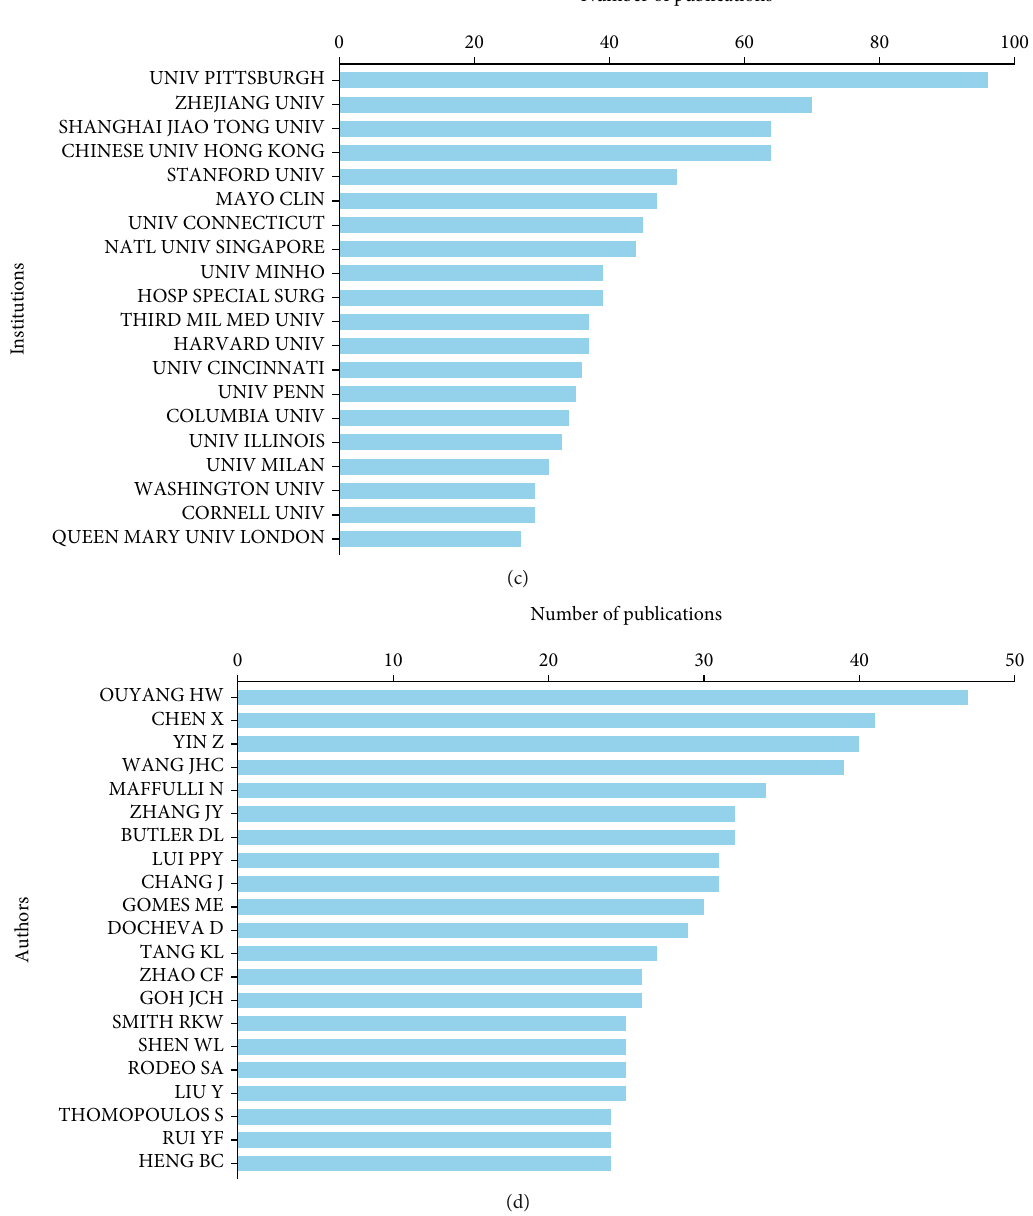
Figure 3: (a) The top 20 journals with most publications related to the research of tendon stem cells. (b) The 20 research orientations and the number of publications in each orientation. (c) The top 20 institutions of high-impact and the number of their publications. (d) The top 20 authors with most publications in this fi